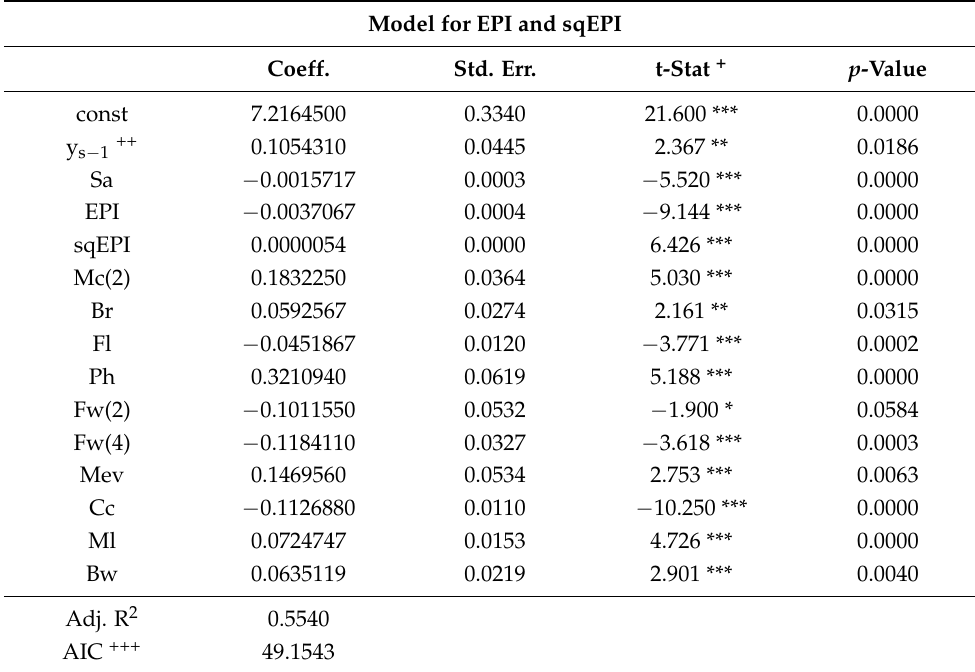
Table 3. Results for the spatial autoregressive model with the quadratic term of EPI. Model for EPI and sqEPI Coeff.